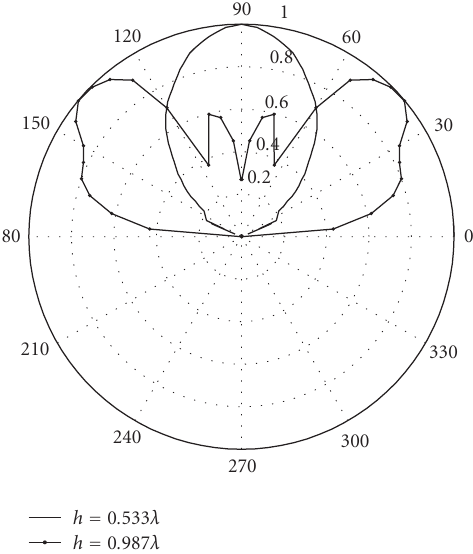
Figure 9: E -plane patterns for ε r = 1 . 0, h = 0 . 533 λ , and h = 0 . 987 λ